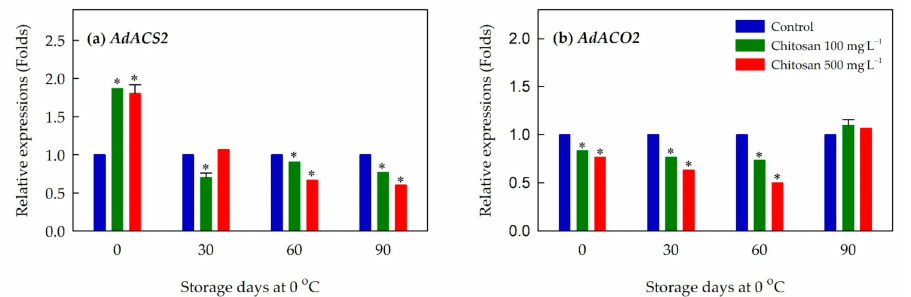
Figure 4. Effects of preharvest chitosan application on relative expression of ethylene biosynthesis- related genes ( a ) AdACS2 and ( b ) AdACO2 during cold storage in ‘Garmrok’ kiwifruit. Vertical bars indicate SE with n = 3. Actin gene was used as internal control and the quantitative RT-PCR data were analyzed using the 2 − ∆∆ CT method. * Statistical difference caused by chitosan treatment was compared to untreated fruit (control) of each sampling date ( p ≤ 0.05).